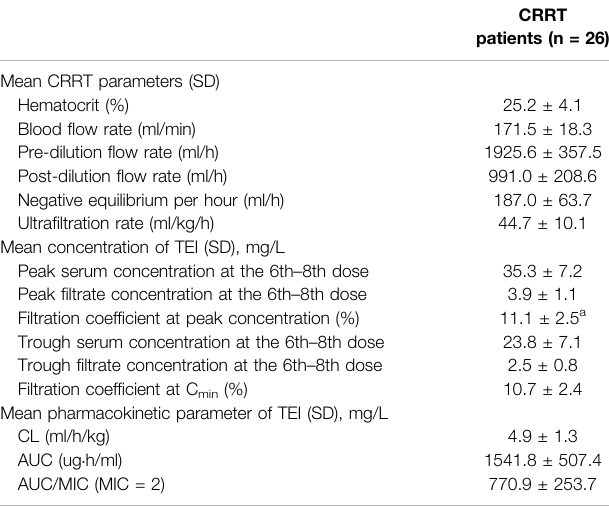
CRRT patients (n = 26)